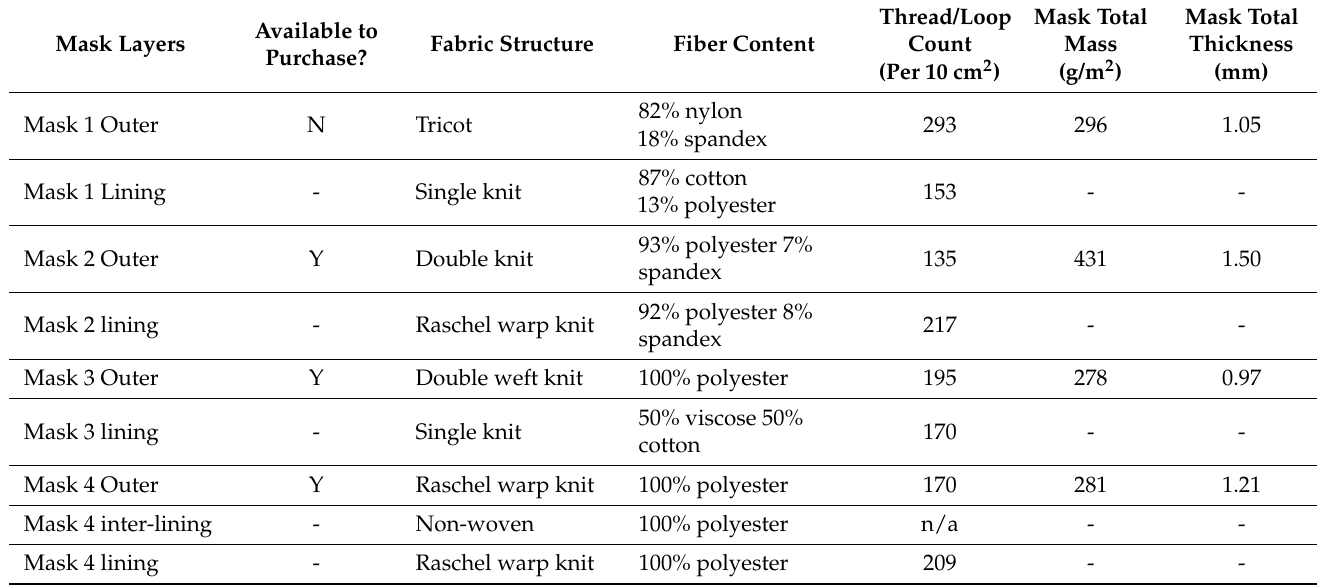
Table 1. Characteristics of Masks used in the